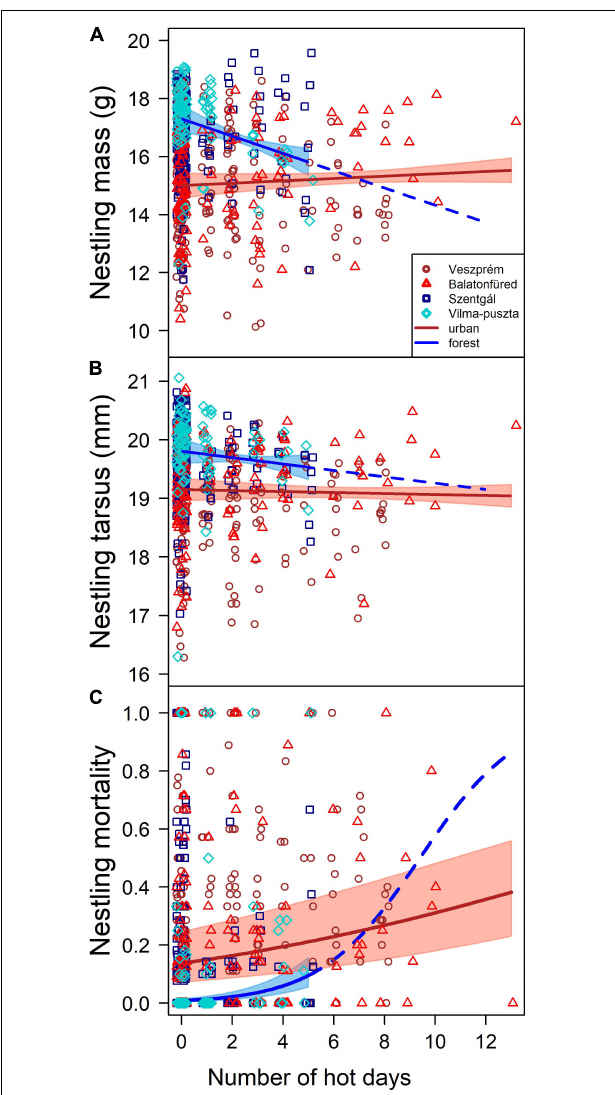
FIGURE 2 | Relationships between the number of hot days during the nestling period and (A) body mass, (B) tarsus length, and (C) mortality of great tit nestlings. Symbols represent brood means for nestling mass and tarsus length. Colored stripes show the 95% confidence band of the slope estimated from the simple models ( Supplementary Table 6 ). For forest broods, the fitted slopes are extrapolated for the range of 5–13 hot days (dashed lines) using the slopes estimated by the models from the observed data. Note that all urban-forest comparisons remained qualitatively the same when the analyses were restricted to a subset of data where the number of hot days ranged from 0 to 5 (see Supplementary Material, Section 7 , Supplementary Table 7